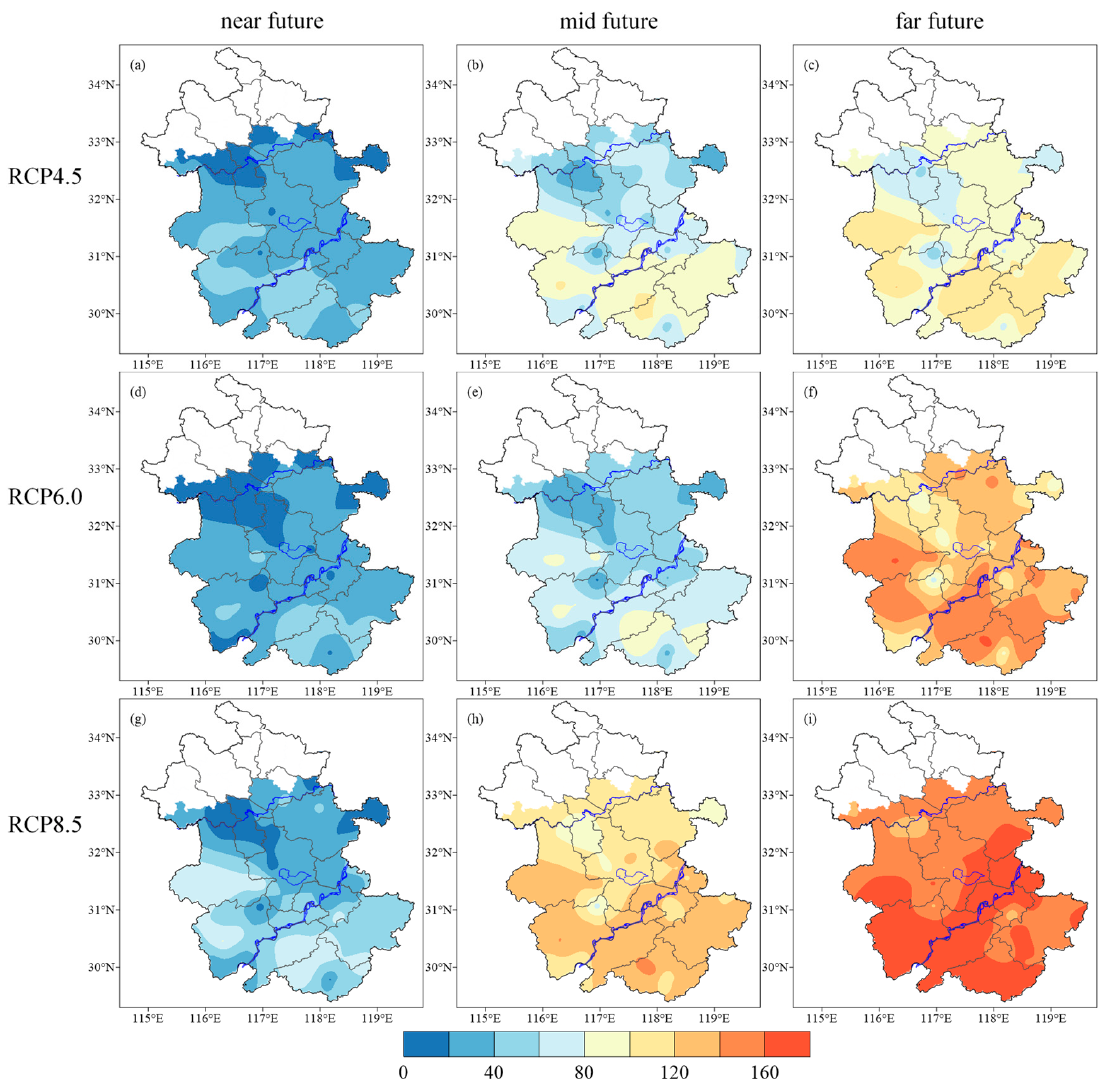
Figure 9. Spatial distribution of payout differences compared with the reference value in different periods from 2021 to 2099 under 3 RCPs in the area south of the Huai River in Anhui Province. ( a ) near future under RCP4.5; ( b ) mid-future under RCP4.5; ( c ) far future under RCP4.5; ( d ) near future under RCP6.0; ( e ) mid-future under RCP6.0; ( f ) far future under RCP6.0; ( g ) near future under RCP8.5; ( h )mid-future under RCP8.5; ( i )far future under RCP8.5.